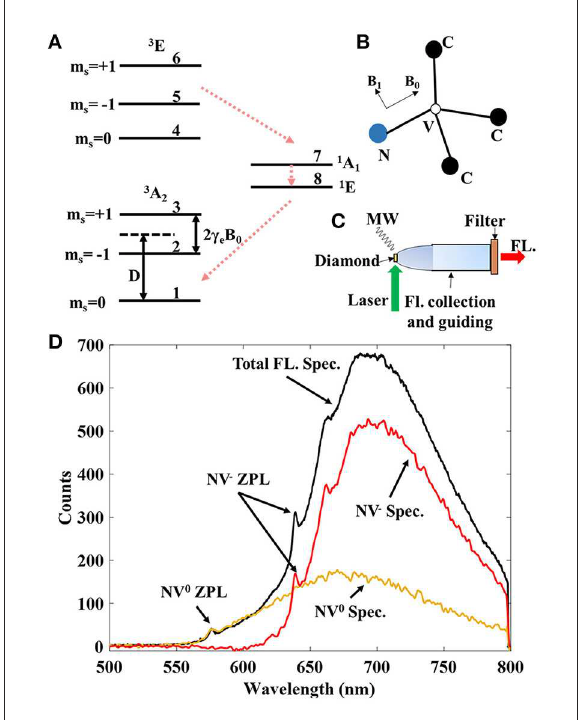
FIGURE1 (A) Energy level diagram of negatively charged NV center in diamond. The bias field B 0 degenerate the m s 1 states by = ± 2 γ e B 0 . The zero-field splitting is D 2.87GHz. The numbers are ≈ used to label the different levels. (B) Structure of NV center in diamond. The applied B 0 field is parallel to the N-V orientation, and the applied driving field B 1 is supposed to be perpendicular to the N-V axis. (C) A typical setup of the NV magnetometer. The green laser is illuminated on the diamond, which is assembled with the optics to collect and guide the fluorescences for detection. The microwave field is used for resonant driving of the spin states. (D) Fluorescence spectrum (the highest black line) emitted by NV center ensembles in a 0.5 3 mm 3 diamond. The signals from the two different charge states, i.e., NV − (the middle red line) and NV 0 (the lowest yellow line) centers, are estimated in the